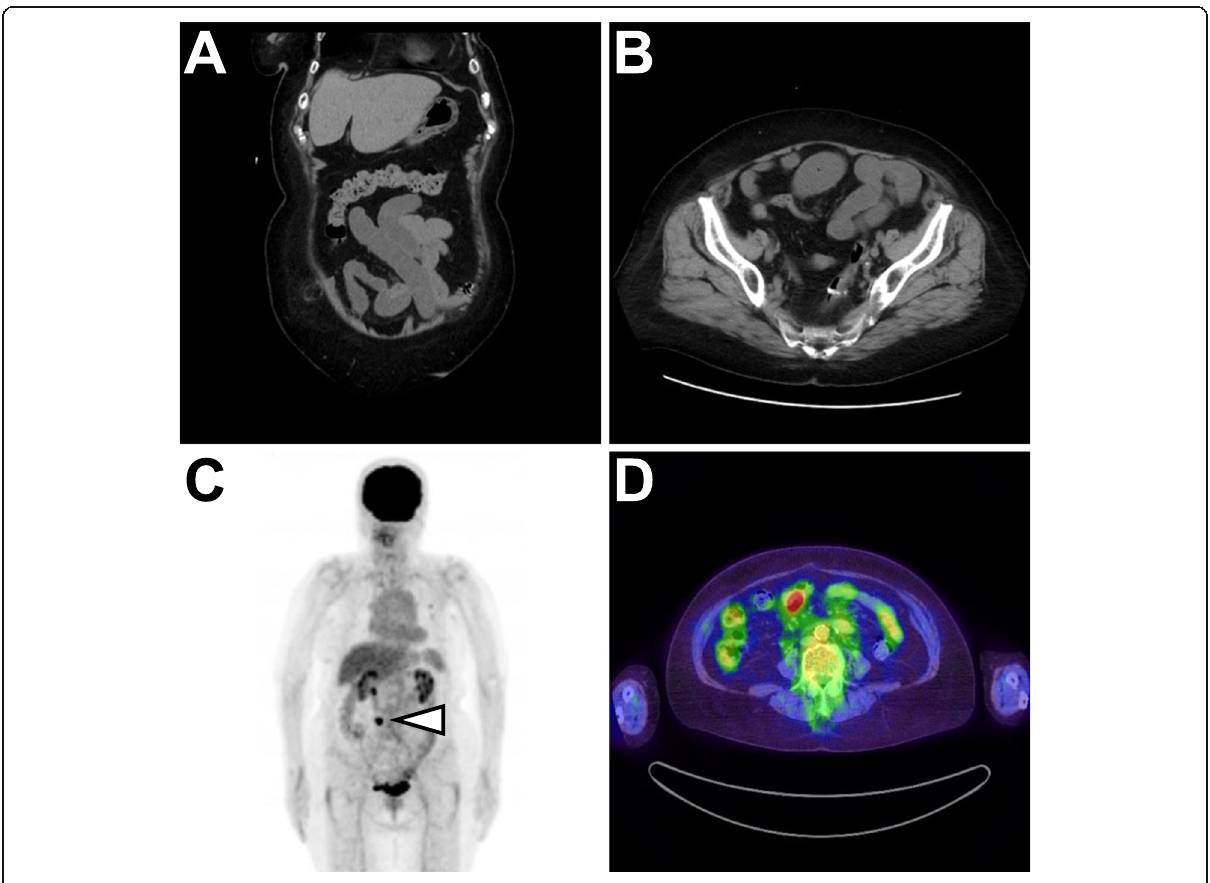
Fig. 1 Radiological findings of the small intestinal tumor. a Coronal and b axial sections of the computed tomography scan. c Fluorodeoxyglucose positron emission tomographic scan showing an abdominal nodule (arrowhead). d The nodule is located on the small intestinal wall. The maximum standardized uptake value of the nodule was